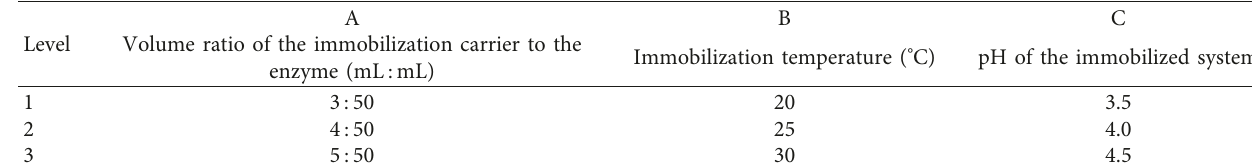
Table 1: Factors and levels of the orthogonal